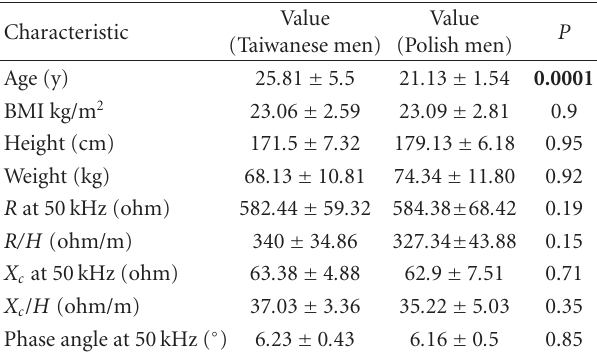
Table 4: Electrical tissue properties characteristics of the Taiwanese and Polish college female students 1